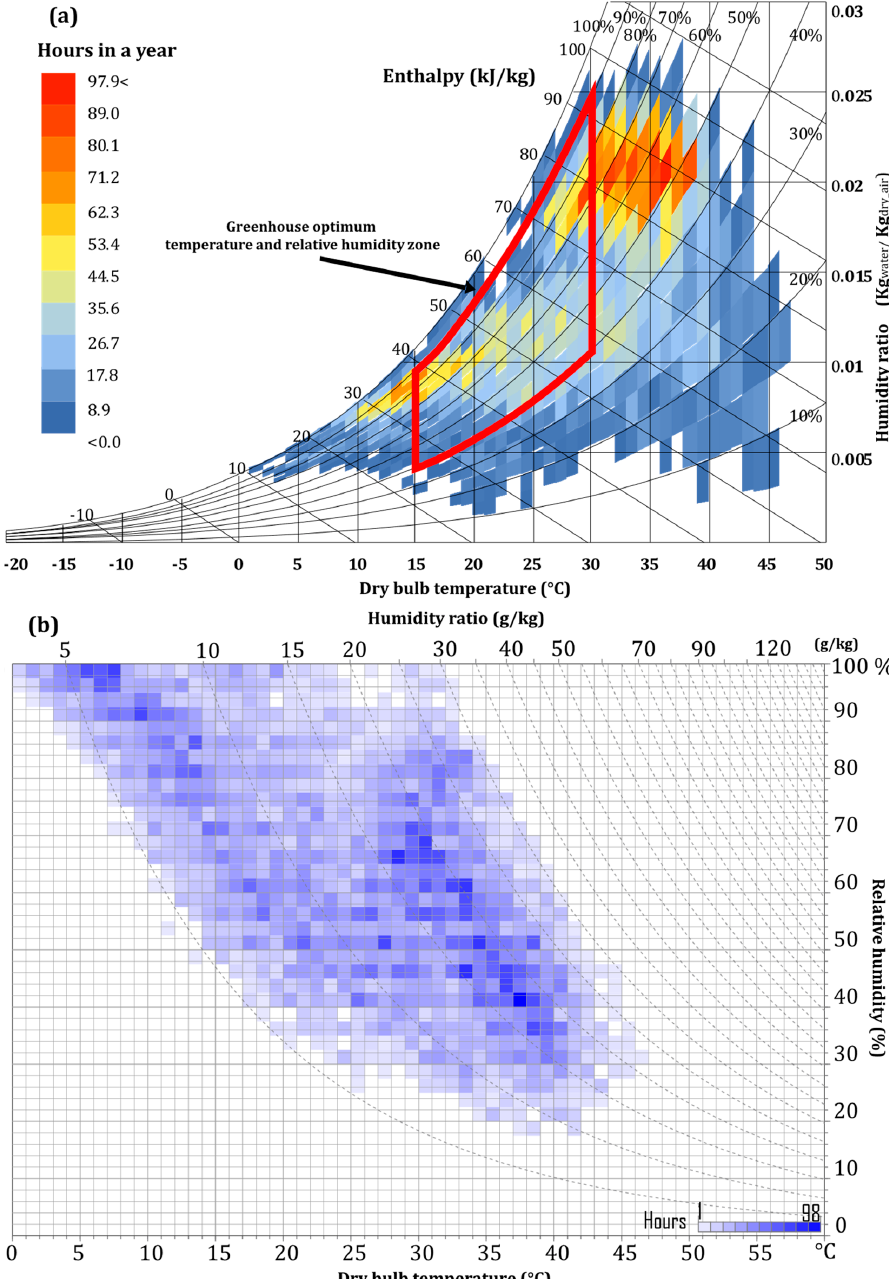
Figure 3. Ambient climatic conditions of Multan (Pakistan) on ( a ) psychrometric chart, and ( b ) relative humidity chart.